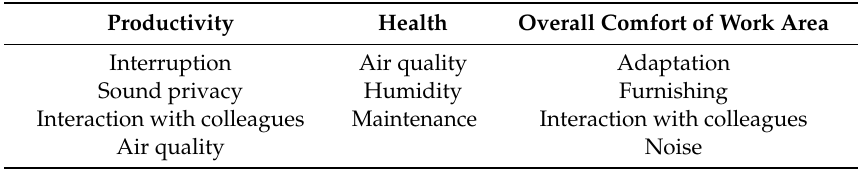
Table 5. Ranking of best-performing features of private o ffi ces for predicting perceived productivity, health, and overall comfort of work area.